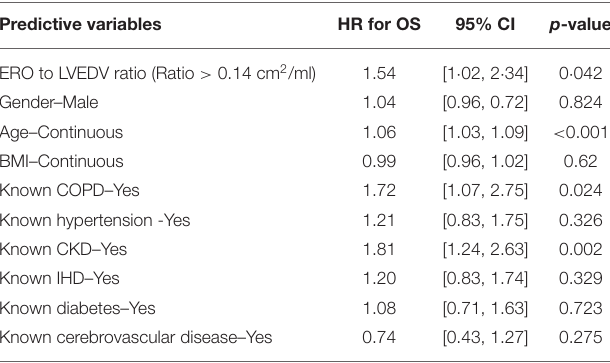
TABLE 4 | Multivariable Cox-regression analysis of MR defined by ERO/LVEDV > 0.14 mm 2 /ml. Predictive variables